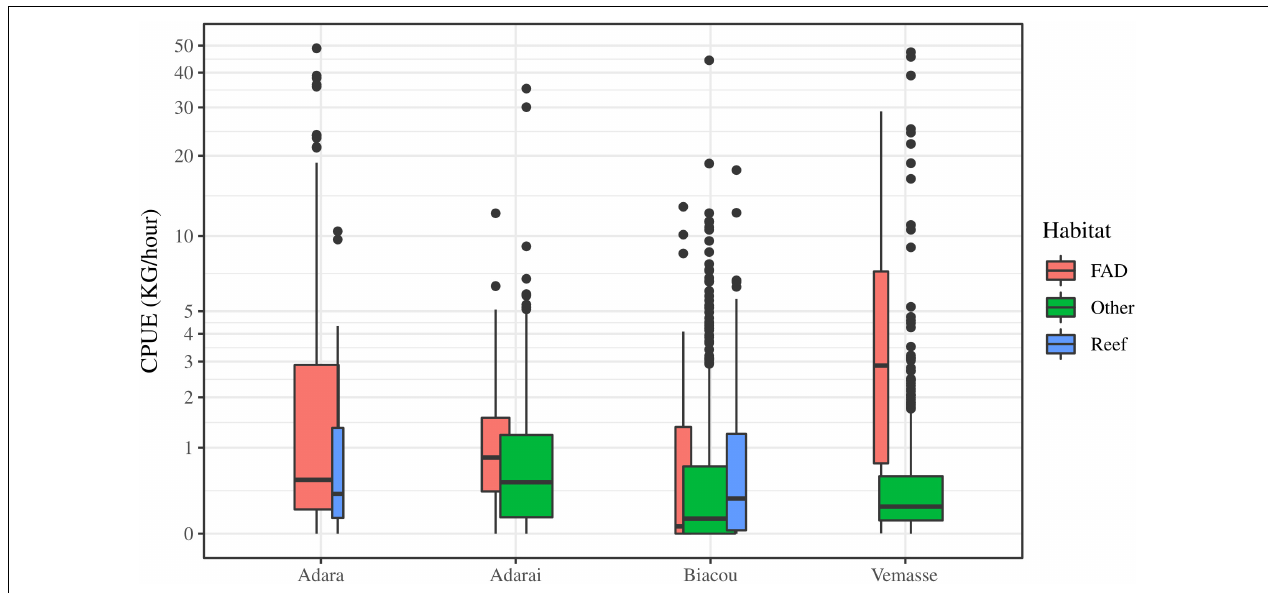
FIGURE 3 | Comparison of catch rates of FAD fishing, reef fishing, and other fishing across four sites in Timor-Leste using the weight of fish per fisher hour on a log axis (data untransformed). Trip records other than to FADs and reefs in Adara are not shown due to the low number of observations ( n = 7). Box width is proportional to the number of observations for each site/habitat combination. Box midlines reflect the median values, box boundaries show lower and upper hinges (first and third quartiles – or 25th and 75th percentiles), and whisker limits are 1.5 × interquartile range. Outliers beyond these limits are shown as points.